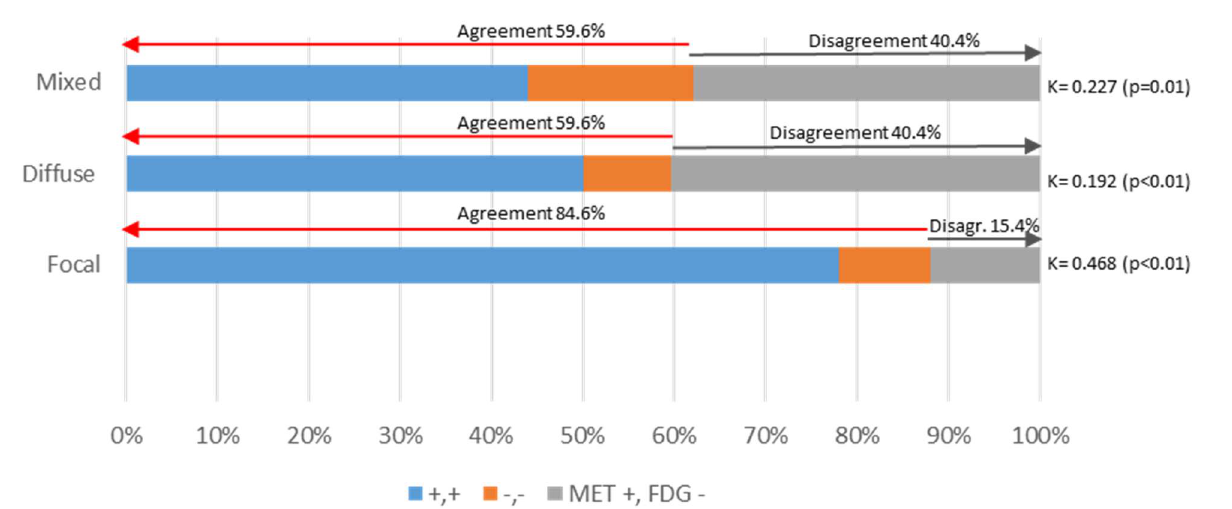
Figure 5. Concordance in FL and BM detection between MET and FDG PET/CT. The bar chart represents differences in the metabolic patterns detected by MET and FDG PET/CT.